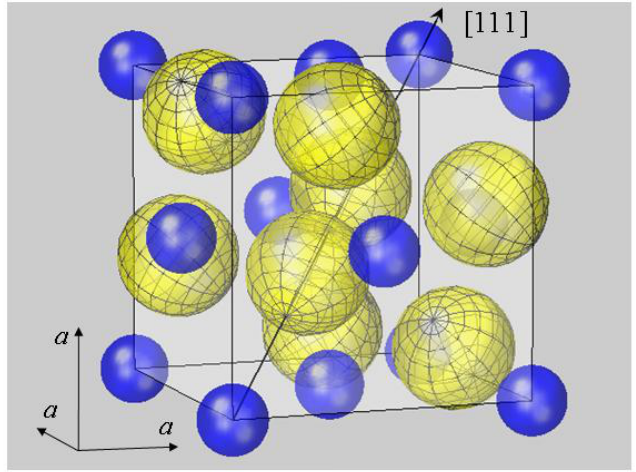
Figure 1. Spherical modelling of the pyrite unit cell (space group 3 Pa ). While Fe 2+ ions (blue) form an fcc lattice, sulfur ions (yellow) reside on <111> axes, as described by positional parameter u . In FeS u amounts to 0.38484 in fractional coordinates of the unit 2 cell [38]. The body diagonal is shown as an arrow. S ions form dumbbells, and there are four S dumbbells in the unit cell. Only the dumbbell at ( uuu ) and ( uuu ) appears 2 undivided, while the remaining S dimers all extend from the cell shown into neighboring 2 cells. In order to visualize the different site symmetries, a mesh is inscribed into S ion spheres with poles lying on <111> symmetry axes. All ions are modelled by spheres with radii r for Fe 2+ and half the S–S bond distance d /2 for S − . With this setting, Fe and S MSP SS spheres have contacts with none or only one neighbor, respectively. This result also holds for the other compounds listed in Table 1. Such a spherical packing would be unstable in terms of packing theory [2], demonstrating the failure of the ionic radius concept in the case of pyrite-type